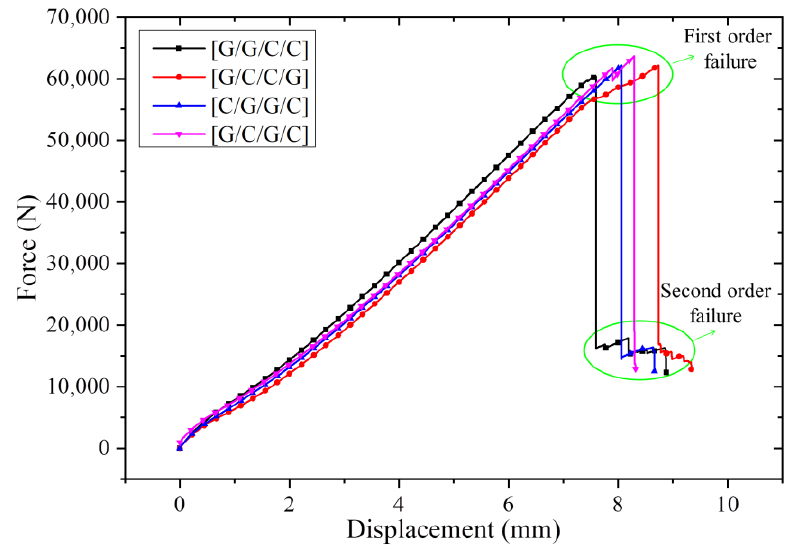
Figure 5. Tensile force–displacement curves of interlayer hybrid composites with C:G = 1:1.